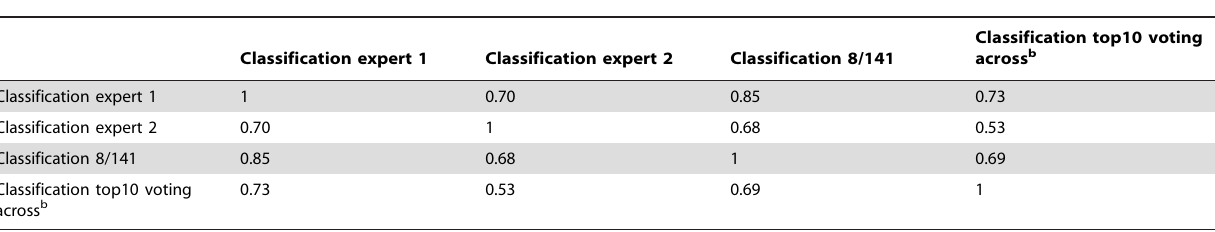
Table 3. Human and machine judgements on data set 2.